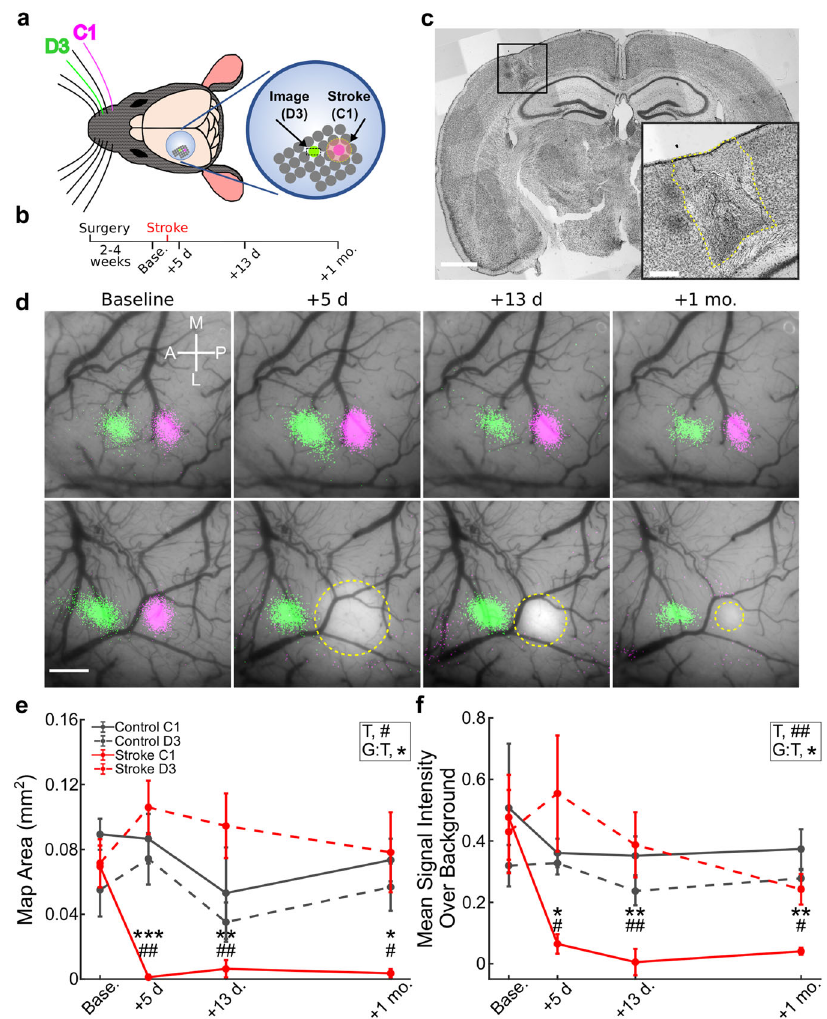
Fig. 1 Intrinsic signal imaging reveals no evidence of macroscopic remapping after C1-targeted photothrombotic strokes. a Left: schematic of cranial window placement and whiskers for stimulation. Right: enlarged view showing locations of the stroke (C1, magenta) and spared barrel (D3, green) highlighted. b Experimental timeline: ISI and 2P imaging were carried out at baseline (before stroke) and + 5 days, + 13 days, and + 1 month after stroke. c Cresyl violet-stained coronal section from a representative mouse 5 days post-stroke. Scale bar = 1 mm. Inset: higher magni fi cation view of infarct core, outlined in yellow. Scale bar = 250 μ m. d ISI maps elicited by stimulation of C1 (magenta) and D3 (green) whiskers overlaid on photographs of the cranial window in representative sham control (top) and stroke (bottom) mice before and after stroke. Pale areas (yellow outline) represent the infarct. Note that the infarct size appears smaller over time as a result of the disappearance of acute tissue edema and tissue involution/scarring. Scale bar = 0.5 mm. e Quanti fi cation of C1 (solid lines) and D3 (dashed lines) whisker-evoked ISI map area size throughout recovery in control (gray) vs. stroke (red) animals ( n = 4 and 6, respectively). Two-way repeated measures ANOVA, main effects of timepoint (T, # p = 0.042) and group-by-timepoint interaction (G:T, * p = 0.014). Signi fi cance for multiple comparison testing using the Tukey-Kramer procedure of timepoints (compared to baseline; # p < 0.05; ## p < 0.01); and group-by-timepoint interactions (comparing C1 and D3 map area size in the stroke group; * p < 0.05; ** p < 0.01; *** p < 0.01). Data in e and f represent mean ± s.e.m. f Quanti fi cation of C1 (solid lines) and D3 (dashed lines) whisker-evoked ISI mean signal intensity over background signal throughout recovery in control (gray) vs. stroke (red) animals ( n = 4 and 6, respectively). Two-way repeated measures ANOVA, main effects of timepoint (T, ## p = 0.003) and group-by-timepoint interaction (G:T, * p = 0.03). Signi fi cance for multiple comparison testing using the Tukey-Kramer procedure of timepoints (compared to baseline; # p < 0.05; ## p < 0.01;) and group-by-timepoint interactions (comparing C1 and D3 signal intensity in the stroke group; * p < 0.05; ** p <